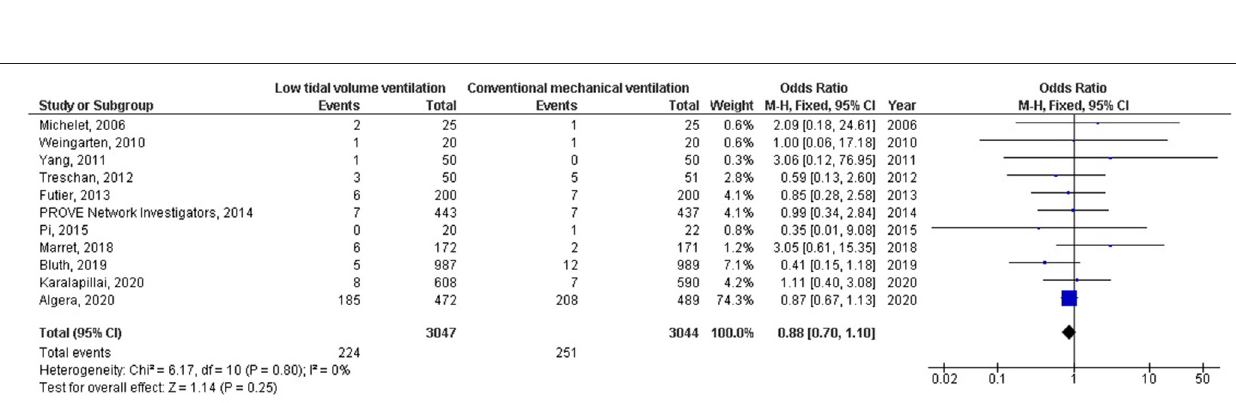
FIGURE 3 | Forest plot of the low tidal volumes strategy vs. conventional mechanical ventilation in subjects undergoing surgery on length of hospital stay.